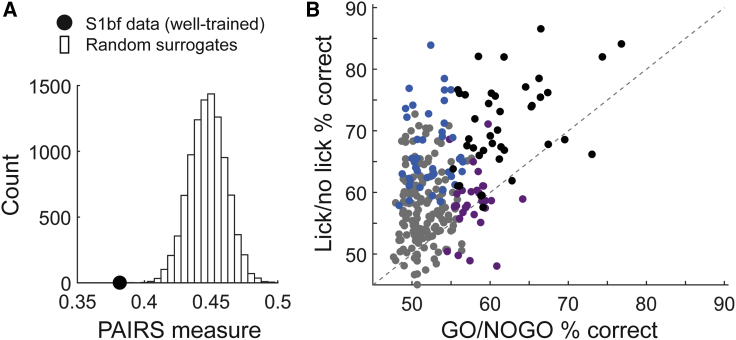
Diverse Response Classes in Well-Trained S1bf(A) Median PAIRS value (index of response similarity) for experimental S1bf dataset compared to distribution for 10,000 random surrogates. The response properties of experimental neurons clustered more than expected by chance.(B) Classification performance (percent correct) supported by individual neurons. Data points shows lick versus no-lick performance plotted against GO versus NOGO performance for each neuron. Black dots: neurons with significant performance on both lick versus no lick and GO versus NOGO. Blue: neurons with significant performance on lick versus no-lick. Purple: neurons with significant performance on GO versus NOGO. Grey: neurons with significant performance on neither. Dashed line: equality.